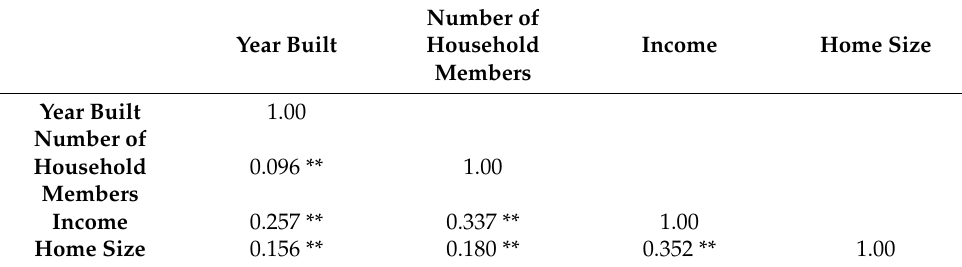
Table 4. Correlation analysis—Cold/Very Cold Climate (Spearman’s ρ ).